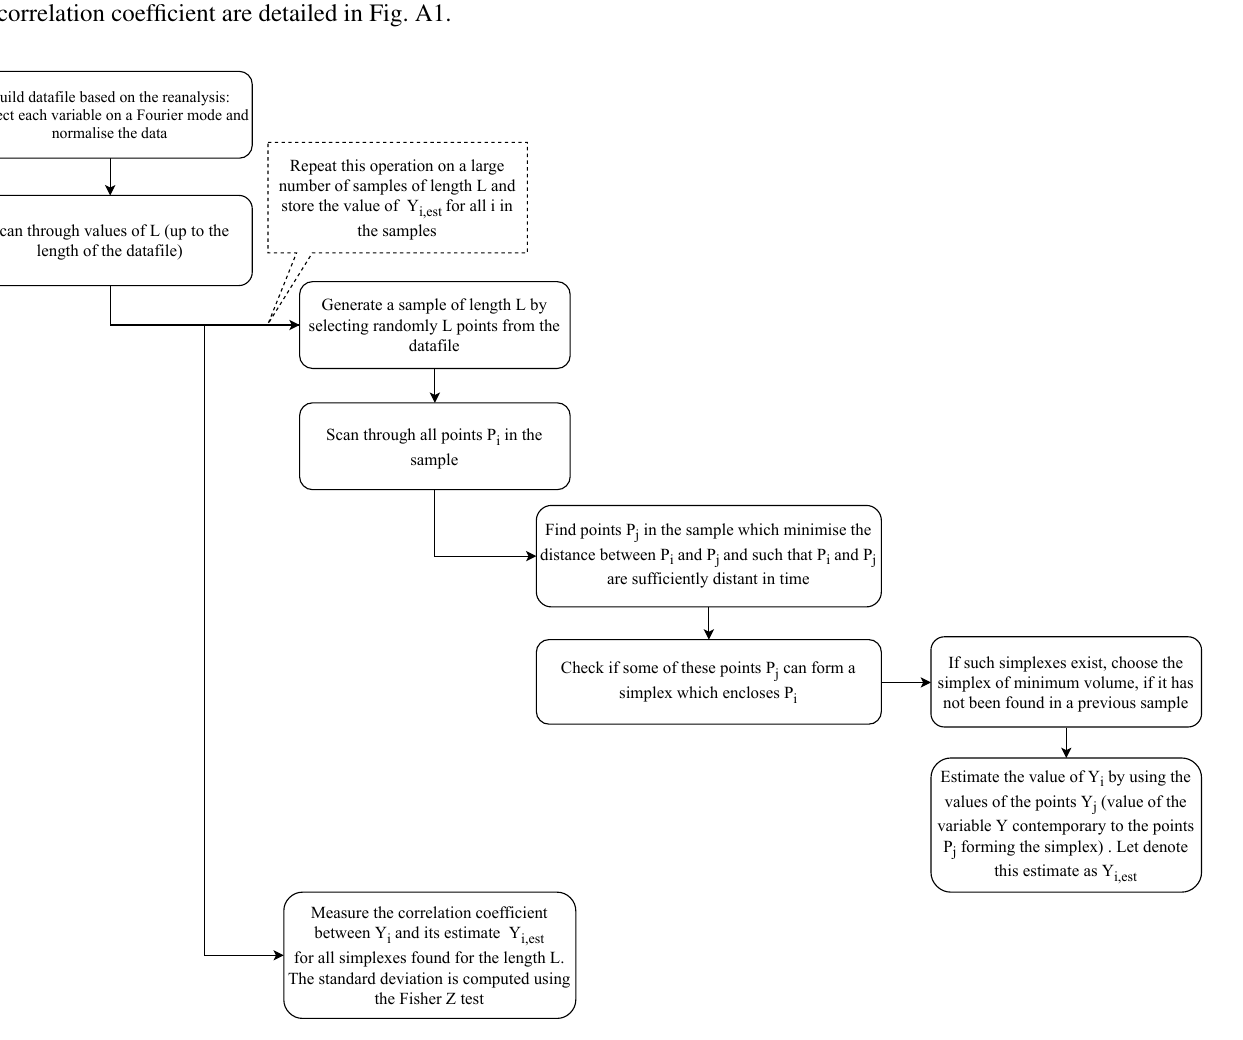
Figure A1. Algorithm used to compute the CCM presented in Sect. 2, based on the series discussed in Sect.